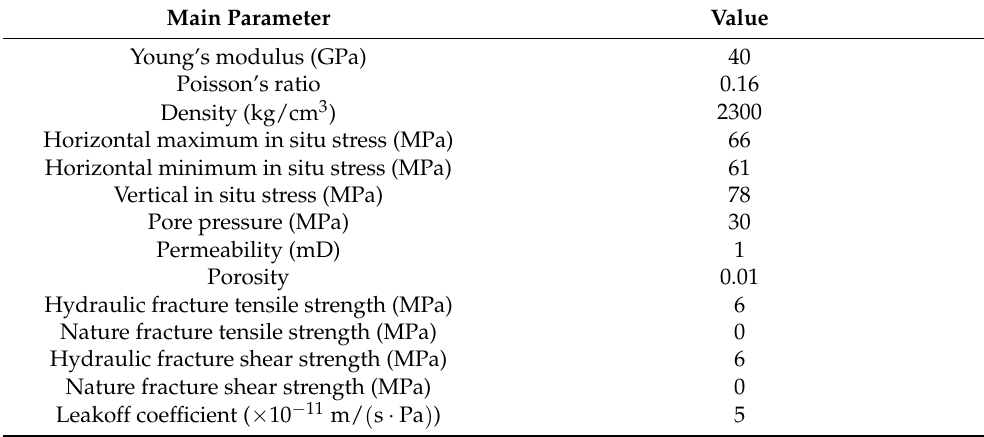
Figure 3. Two sets of randomly generated natural fractures. ( a ) had 27 fractures with the angle of − 20° and 27 fractures with the angle of 80° from the horizontal respectively; ( b ) had 27 fractures with the angle of 40° and 27 fractures with the angle of 140° from the horizontal respectively. The fracturing fluid that was used in the simulation was water; its viscosity was as- sumed to be constant and was taken as 1. The water was injected at a constant flow rate into the center of the model during the fracturing process. The maximum horizontal in situ stress was in the lateral direction of the model and the minimum horizontal in situ stress was in the longitudinal direction of the model. The other parameters that were used in the model are shown in Table 1. Table 1. The simulation parameters.